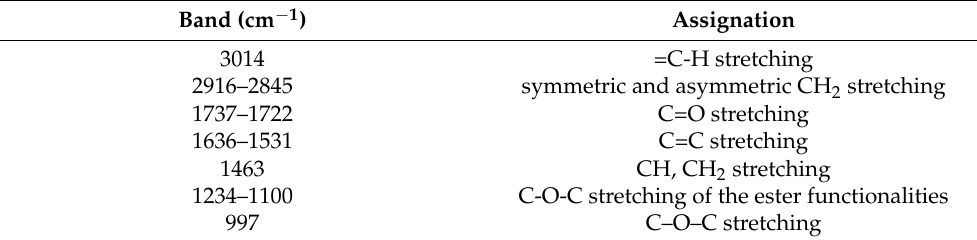
Table 4. Vibrational bands of mineral- and vegetable-based TC prints (TC27 and TC45) and their assignations